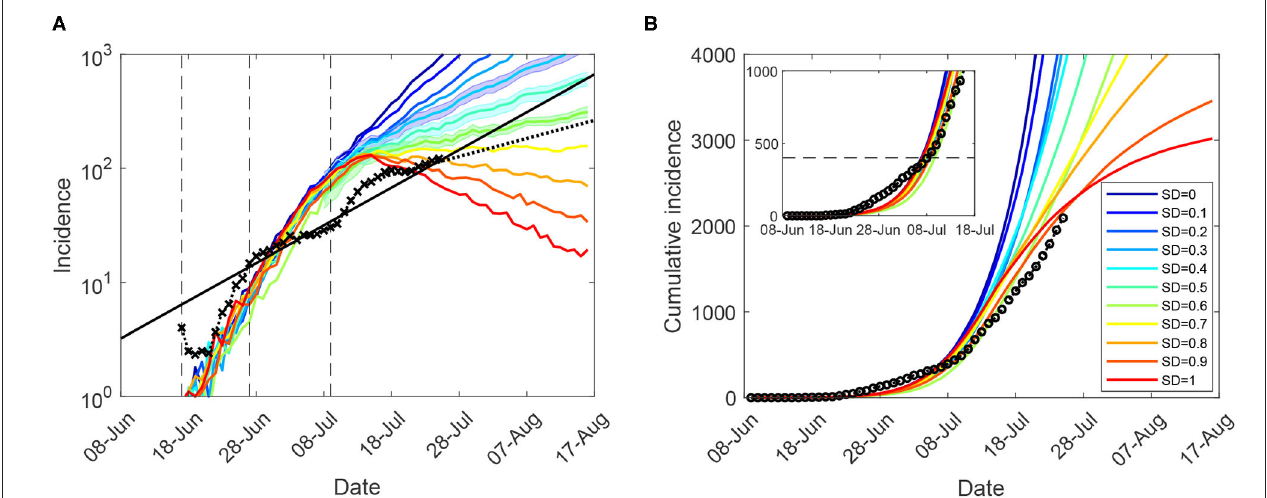
FIGURE 1 | Moderate restrictions (NSW; progressive vaccination rollout; suppression threshold: 400 cases): a comparison between simulation scenarios and actual epidemic curves, under moderate interaction strengths ( CI c = CI w = 0.25, HQ c = HQ w = 0.25, SD c = 0.25, SC = 0.5). A moving average of the actual time series up to 25 July for (A) (log-scale) incidence (crosses), and (B) cumulative incidence (circles); with an exponential fit of the incidence’s moving average (black solid: β II , and black dotted: β III ). Vertical dashed marks align the simulated days with the outbreak start (17 June, day 9), initial restrictions (27 June, day 19), and tighter lockdown (9 July, day 31). Traces corresponding to each social distancing (SD) compliance level are shown as average over 10 runs (coloured profiles for SD varying in increments of 10%, i.e., between SD = 0.0 and SD = 1.0). 95% confidence intervals for incidence profiles, for SD ∈ { 0.4,0.5,0.6 } , are shown as shaded areas. Each SD intervention, coupled with school closures, begins with the start of tighter lockdown, when cumulative incidence exceeds 400 cases ( B : inset). The alignment between